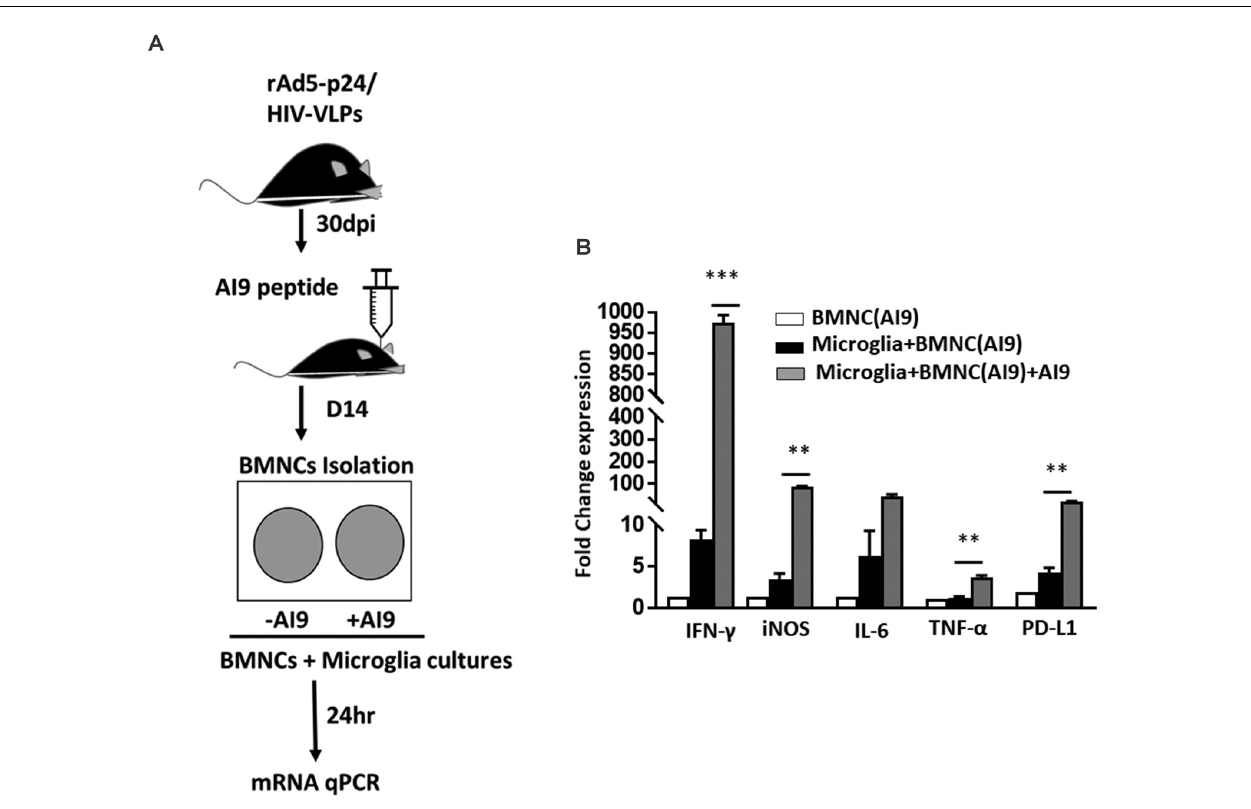
FIGURE 5 | Ex vivo peptide re-challenge resulted in production of pro-inflammatory mediators. (A) Schematic of the experimental design shows that BMNC isolated at d 14 post-challenge were co-cultured with primary microglia. BMNC were either treated with HIV-specific AI9 peptide or left untreated before addition to the microglial cell culture. Real time RT-PCR was performed after 24 h. (B) Bar graph displays fold change in IFN- γ , iNOS, IL-6, TNF- α , and PD-L1 mRNA expression. Expression values were normalized to untreated controls. Data are presented as mean ± SD of two independent experiments using six animals. ∗∗∗ p < 0.001 and ∗∗ p <